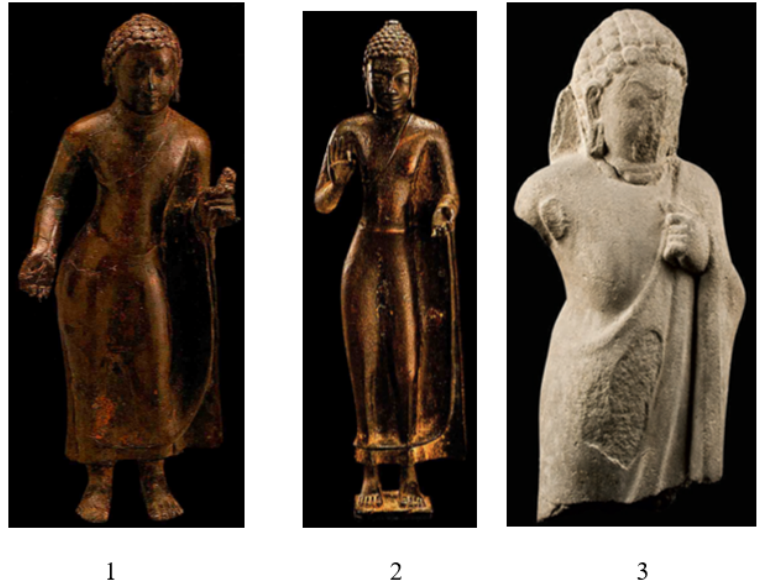
Figure 7. Standing Buddhas with diaphanous robes covering only the left shoulder (type C) in the Malay Peninsula. (1): Buddha, copper alloy, excavated from site 16A, Bujang valley, Kedah, Malay Peninsula, early 6th century (source: Guy 2014, p. 75, CAT. 20); (2): Buddha, copper alloy, Malay Peninsula, Asian Civilization Museum, Singapore, 6th to 7th century (source: Guy 2014, p. 75, CAT. 22); (3): Buddha, sandstone, reportedly found in peninsular Thailand, National Museum, Bangkok, 6th to 7th century (source: Guy 2014, p. 8, figure